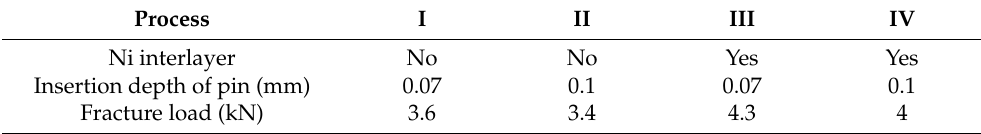
Table 2. Process description and tensile fracture load for FSLW steel/Al.